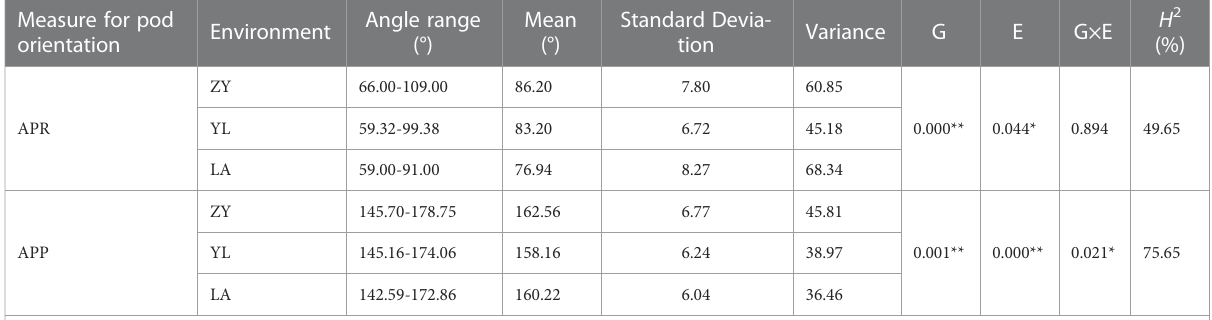
TABLE 1 Summary statistics on the phenotypic variation of pod orientation measured as Angle of the Pedicle to Raceme (APR) and Angle of the Pod to Pedicel (APP) in the 136 rapeseed accessions grown across three environments: ZY: Zunyi; YL: Yangluo, and LA: Lu ’ an. Measure for pod